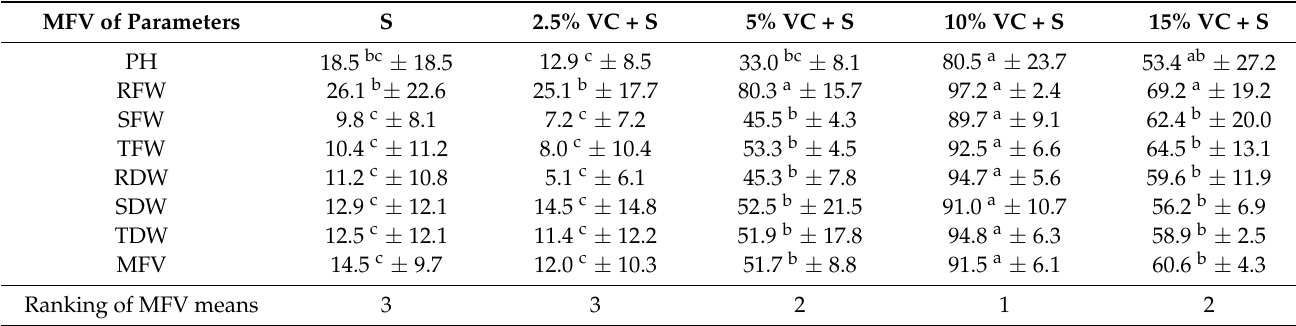
Table 2. Morphology results declared that 2.5 and 10% VC could be selected to test their role in amelioration of salinity stress. Table 2. Membership function value (MFV), ranking of MFV means of plant height (PH), root fresh weight (RFW), shoot fresh weight (SFW), total fresh weight (TFW), root dry weight (RDW), shoot dry weight (SDW) and total dry weight (TDW) under 200 mM NaCl (S), 2.5, 5, 10 and 15%VC treatments of Vicia faba plant after 30 days of cultivation. Values are means ± SD based on triplicate independent determinations, and different letters means significant difference as evaluated by Duncan’s multiple comparison test ( p <